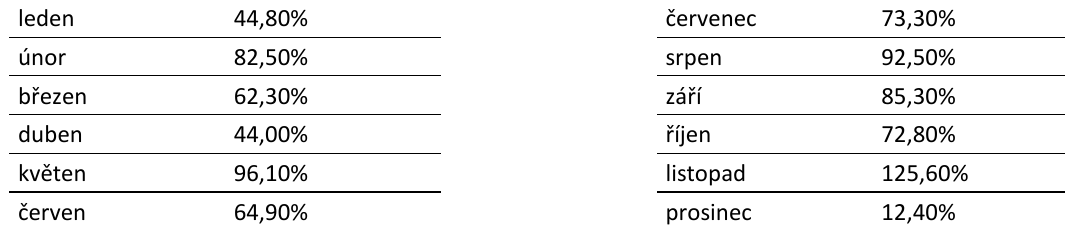
Tabulka 4: Roční diference pro průměrnou nabídkovou cenu rodinného domu v Praze. Obrázek 6 nastiňuje situaci ve Středočeském kraji. Opět je možné sledovat jak vývoj průměrné ceny rodinného domu, tak počtu